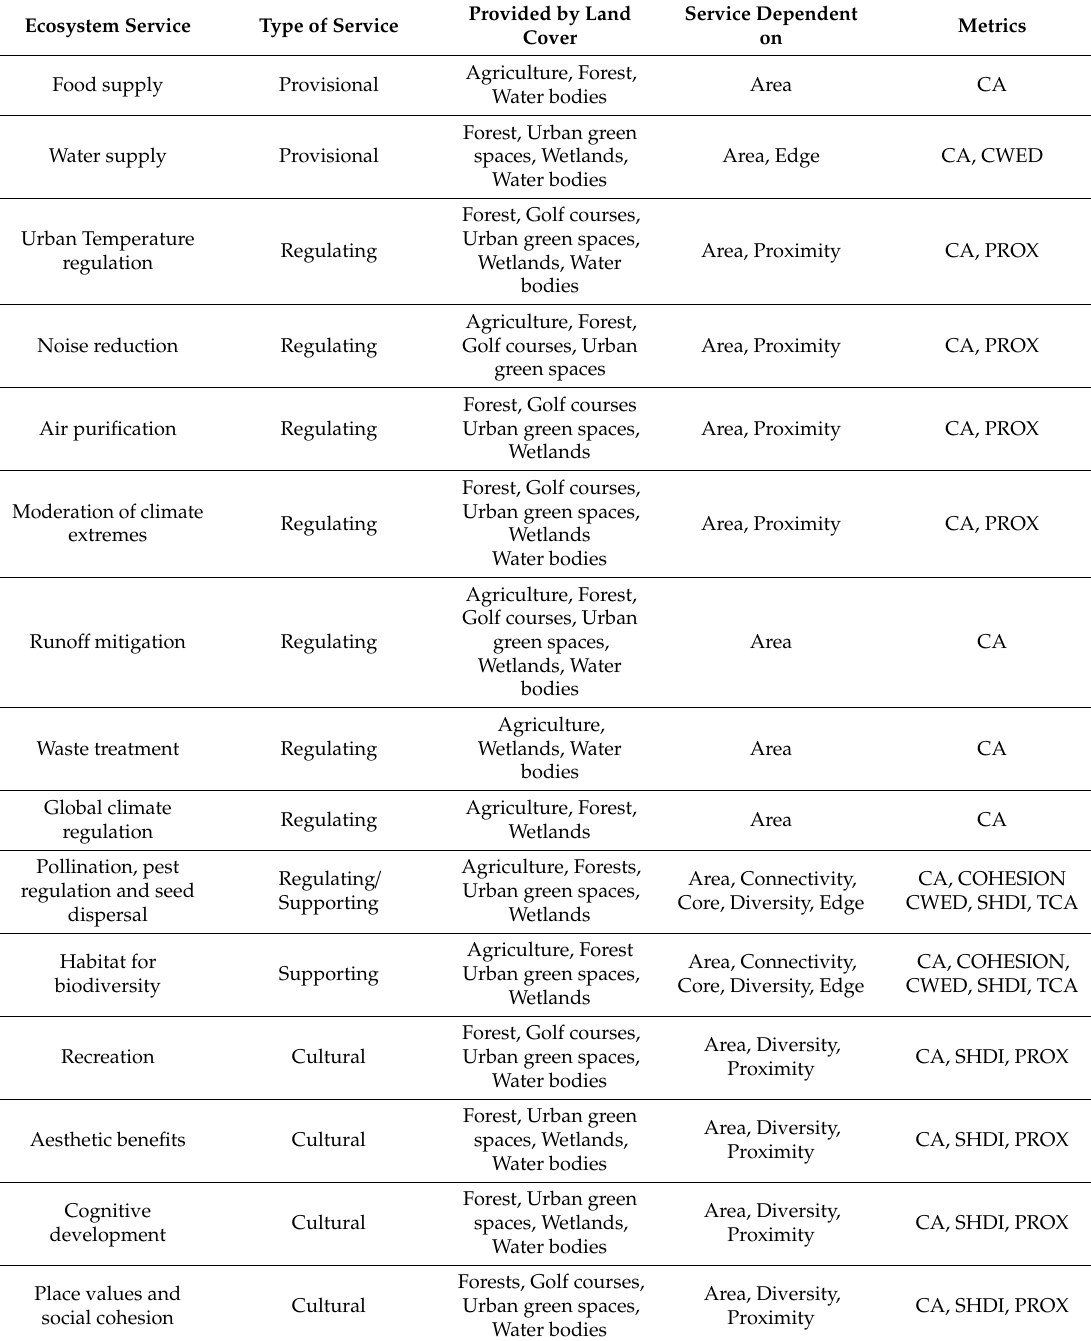
Table 2. Summary of ecosystem services, provisional land-cover classes according to Gomez-Baggethun et al. [54], influential spatial attributes and suggested landscape metrics to quantify these spatial attributes (adapted from Haas and Ban